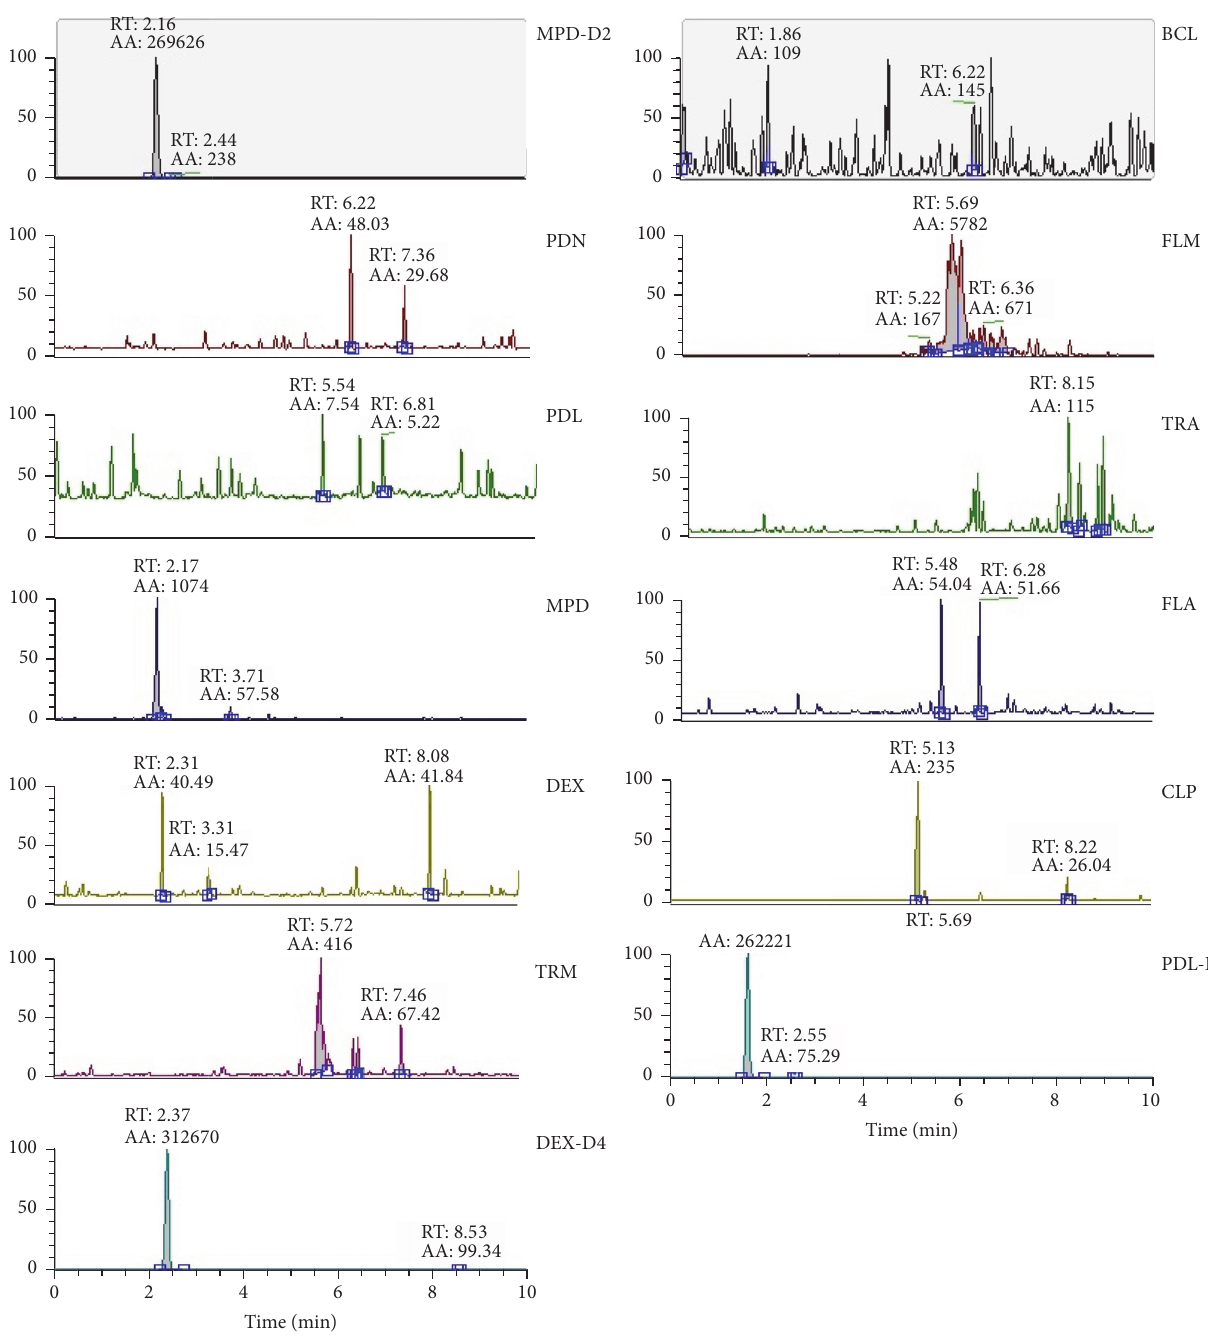
Figure 12: Chromatograms of the corticosteroids (PDN, PDL, MPD, TRM, BCL, FLM, TRA, FLA, DEX, and CLP) and internal standards (MPD-D2, DEX-D4, and PDL-D6) in the blank sample. The relative abundance ( 𝑦 -axis) is reported in percentage (%). AA: peak area; RT: retention